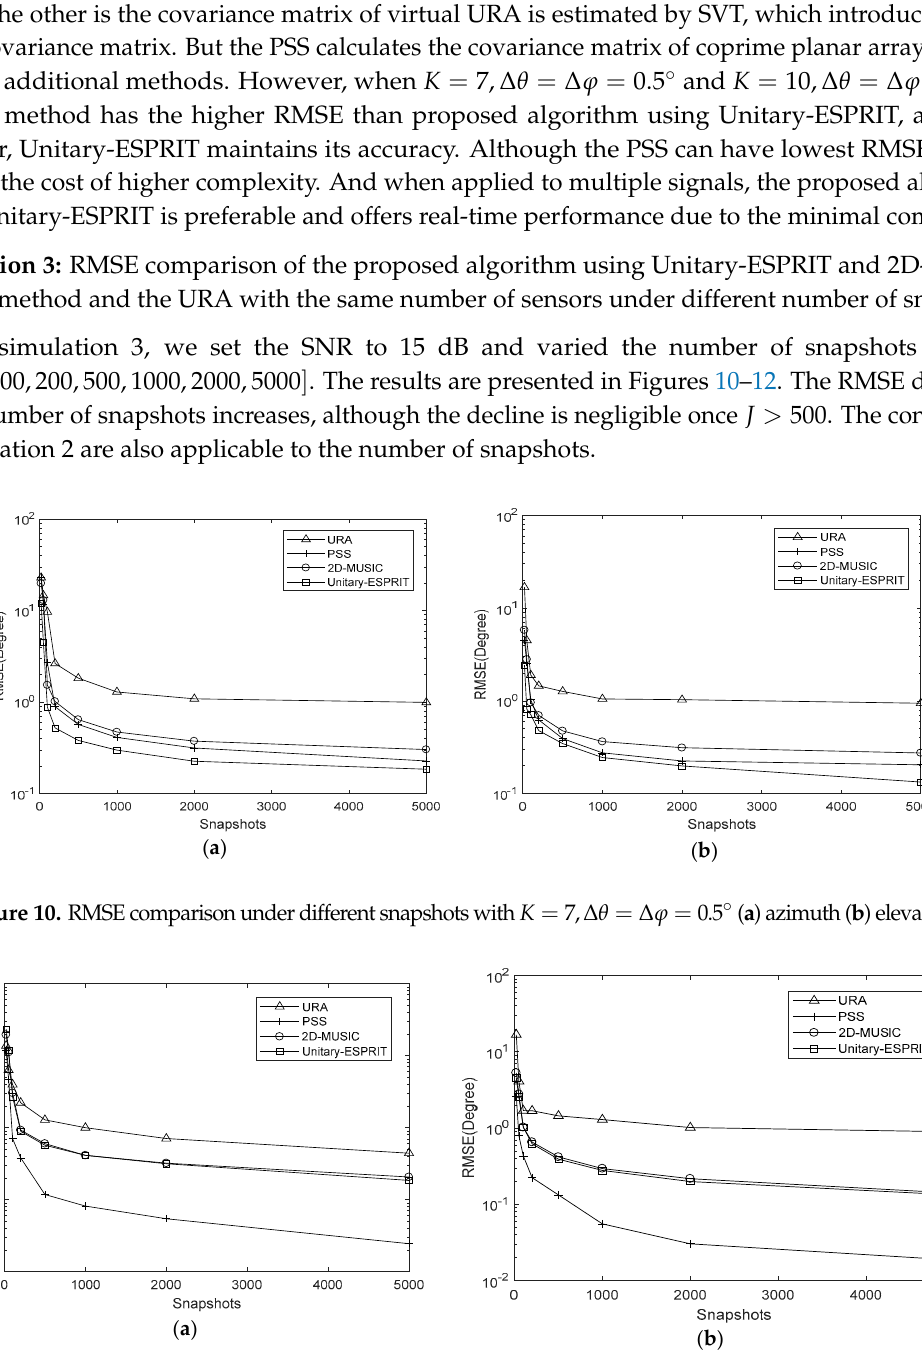
Figure 11. RMSE comparison under different snapshots with K = 7, ∆ θ = ∆ ϕ = 0.05 ◦ ( a )azimuth( b elevation.